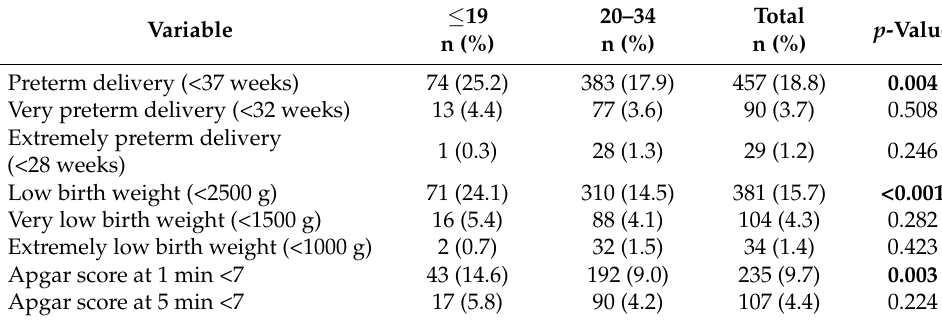
Table 4. Neonatal